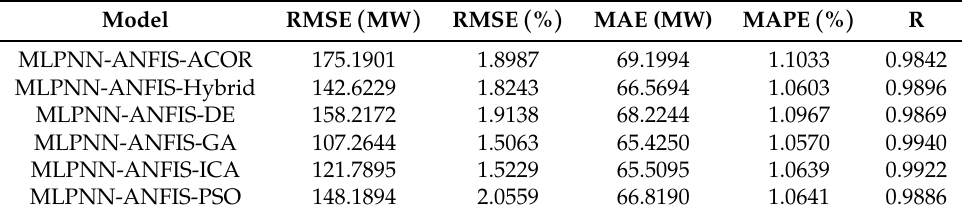
Table 3. Forecasting results for each model.